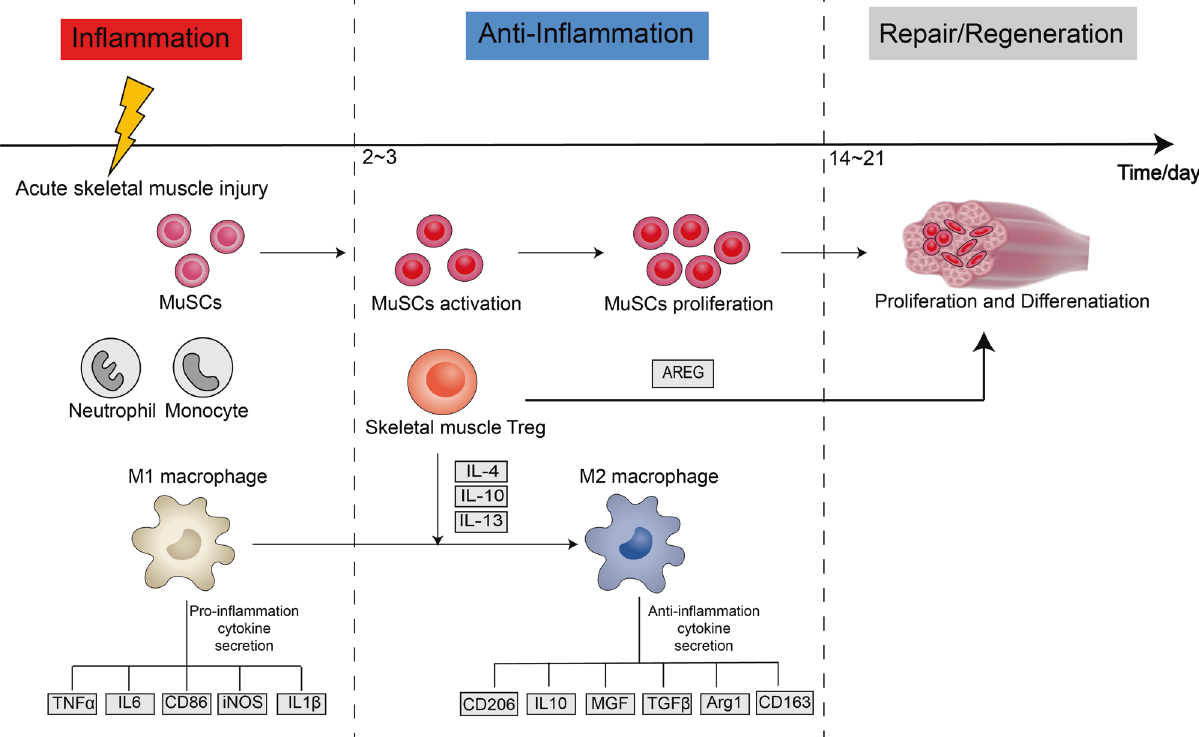
Fig. 2 Schematic illustration of the multi-stage of skeletal muscle repair and regeneration. In the early stage of acute skeletal muscle injury, neutrophils, monocytes, and M1 macrophages secrete various pro-in fl ammatory cytokines to promote the in fl ammatory response. Within 2 – 3 days after injury, the in fl ammatory response state gradually changes to an anti-in fl ammatory state, MuSCs are activated and begin to proliferate, and Tregs promote the conversion of pro-in fl ammatory macrophages to anti-in fl ammatory macrophages and secrete various anti-in fl ammatory cytokines. Tissue remodeling begins two or three weeks post-injury,and MuSCs proliferate, differentiate, migrate, and fuse to form new muscle fi bers; Tregs promote the proliferation of satellite cells, and most immune cells gradually withdraw from the injury site to complete the skeletal muscle repair process. MuSCs, muscle stem cells; TNF- α , tumour necrosis factor-alpha; IL-6, interleukin-6; CD86, cluster of differentiation 86; IL-1 β , interleukin-1 β ; iNOS, inducible nitric oxide synthase; CD206, cluster of differentiation 206; IL-10, interleukin-10; MGF, mechanical growth factor; TGF- β , transforming growth factor-beta; Arg1, arginase1; CD163, cluster of differentiation